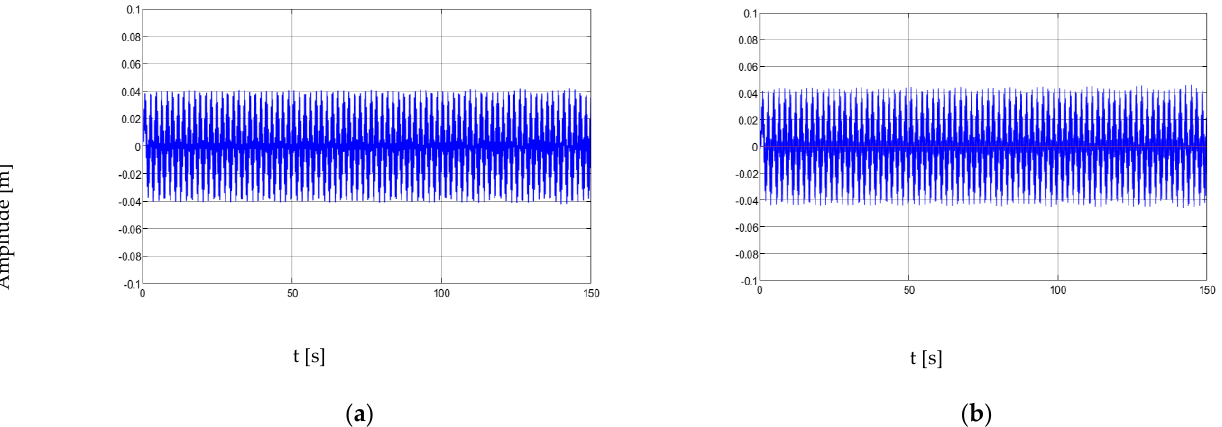
Figure 5. The system response in the case of active force 𝐹 𝐴1 action on the inertial elements (II method of reduction): ( a ) 𝑚 4 , ( b ) 𝑚 1